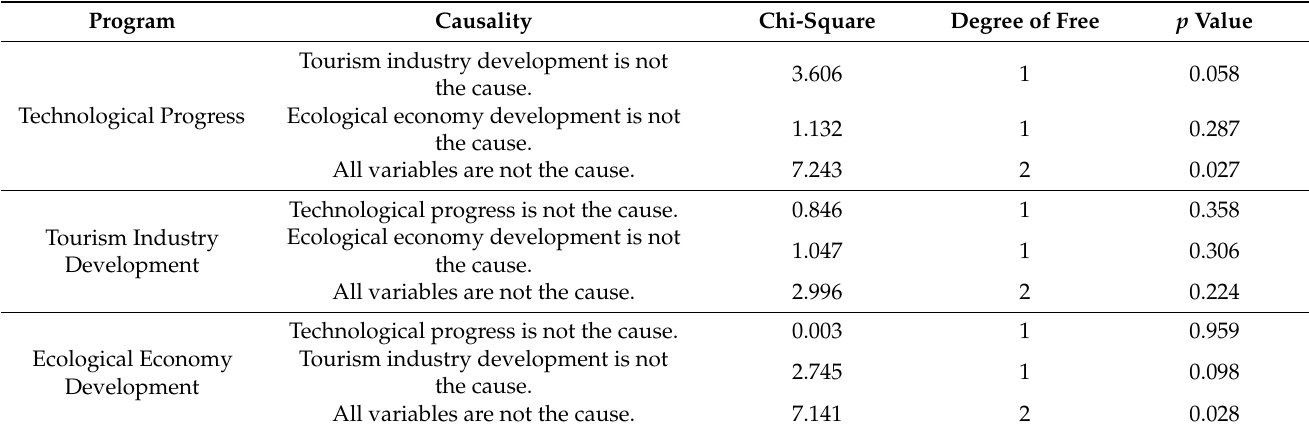
Table 7. Granger causality test